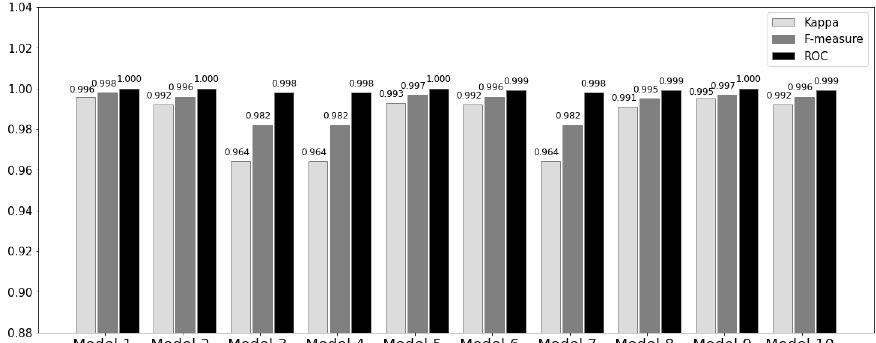
Figure 6. Performance of all